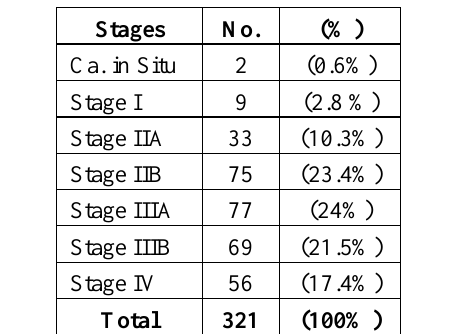
Table VIII. Staging of breast cancer cases